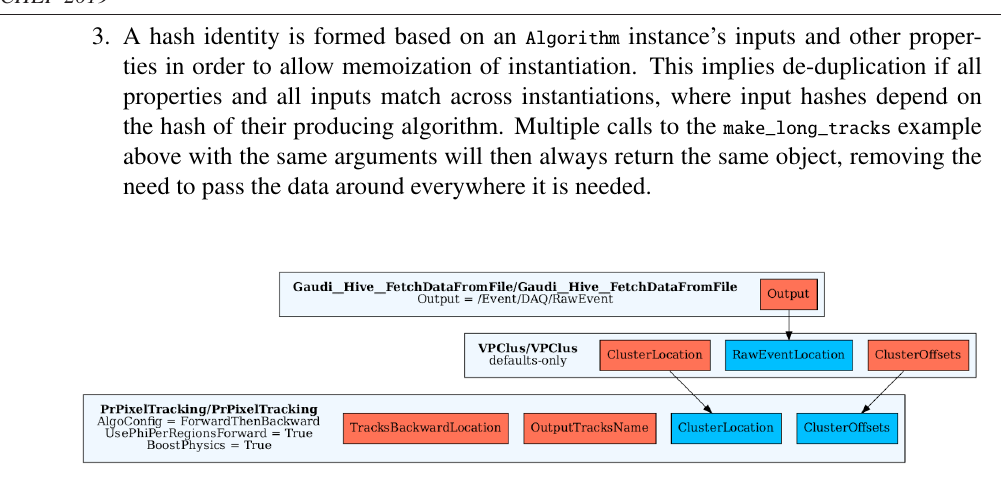
Figure 4. An example dataflow graph, generated by calling the plot method on the Python data repre-